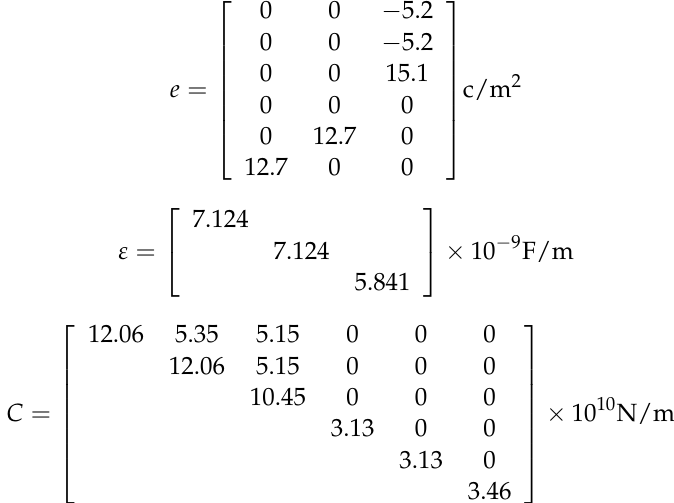
and C donates the elastic stiffness constant